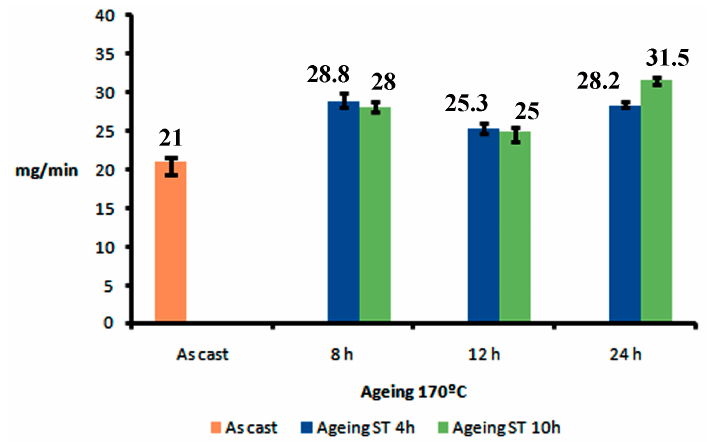
Figure 6. Weight losses suffered during the erosive wear test (ASTM G76) employing compressed air blasting with corundum particles at 4 bar, with a 30 ◦ angle of incidence. Five repetitions were performed in each test. The error bars show the distance between the maximum and minimum values and the mean value.